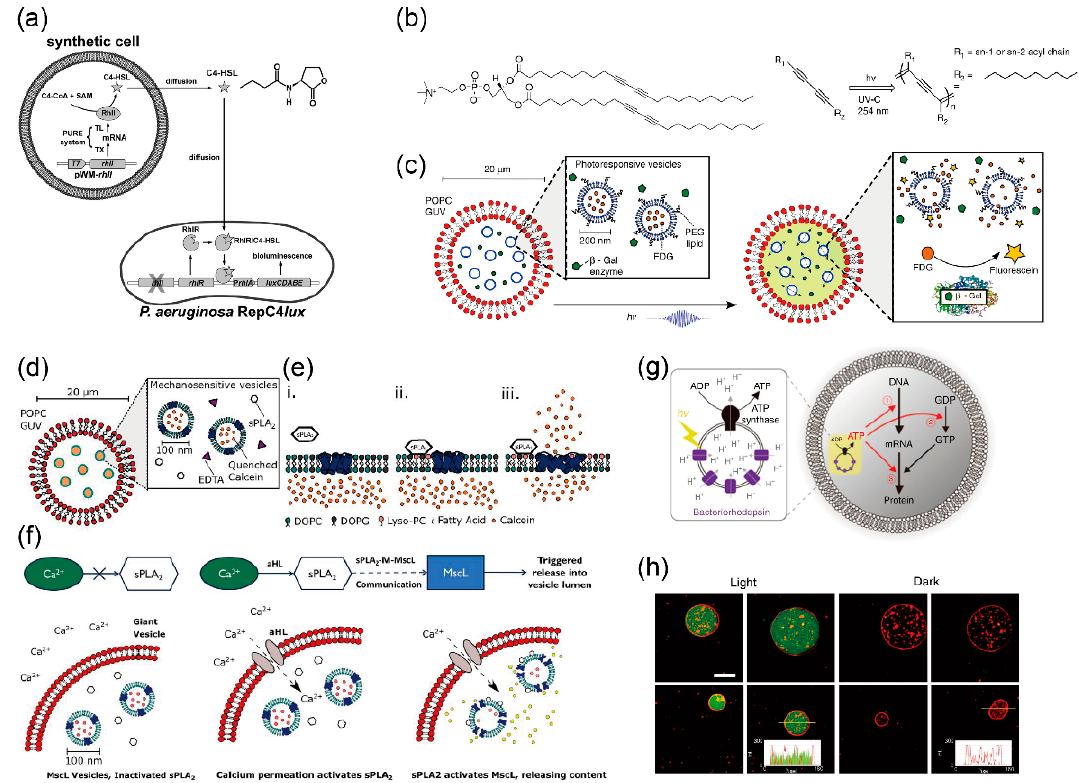
Figure 6. ( a ) Schematic illustration of semi-synthetic minimal cells sending quorum sending signal molecules to P. aeryginosa ; reproduced with permission from [141]. ( b ) Chemical structure of 1,2-bis(10,12-tricosadiynoyl)-sn-glycero-3-phosphocholine (DC89PC) as photo-responsive lipid; ( c ) schematic illustration of artificial cell models containing nano-sized lipid vesicles by UV-response. The nano-sized DC89PC vesicles containing substrate fluorescein di-beta-D-galactopyranoside (FDG) and the enzyme β -galactosidase are coencapsulated into the giant lipid vesicles. (( b , c ) are reproduced with permission from [144].). ( d ) Schematic illustration of artificial cells containing phospholipase A2 enzyme, EDTA, and mechanosensitive channel of large conductance (MscL) reconstituted into the nano-sized lipid vesicles including quenched calcein. ( e ) Reaction of phospholipase A2 (PLA2) on the nano-sized lipid membranes. ( f ) Synthetic mechanosensitive signaling pathway. Due to α -hemolysin ( α HL) into the giant lipid vesicle membranes, calcium ions are transferred to the inner phase of the giant lipid vesicles. The PLA2 function activates the PLA2-membrane-MscL pathway, resulting in content release within the inner phase of the giant lipid vesicles. (( d – f ) are reproduced with permission from [145].). ( g ) Schematic illustration of artificial photosynthetic cells encapsulating artificial organelle containing bacteriorhodopsin and ATP synthase. ( h ) Green fluorescent protein synthesis inside the giant lipid vesicles driven by UV-light. (( g , h ) are reproduced with permission from